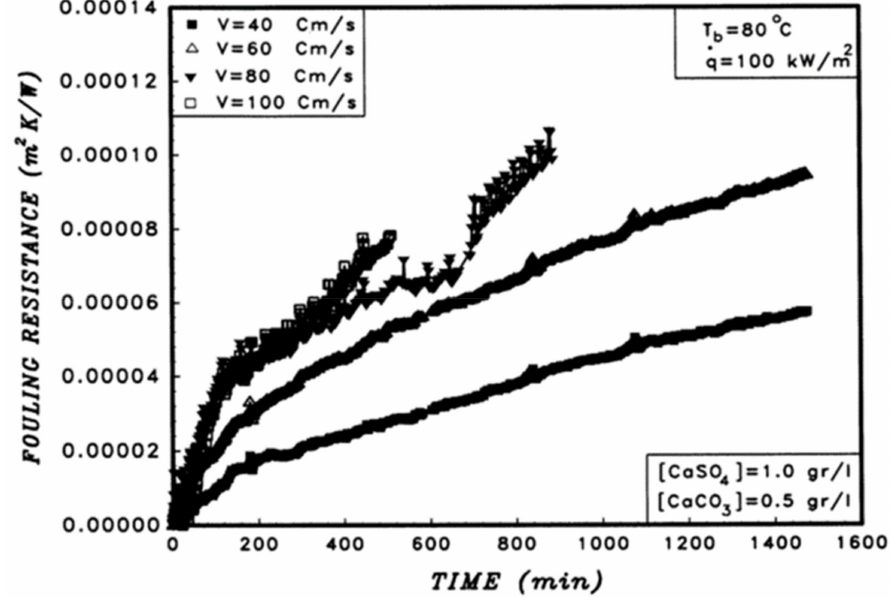
Figure 11. Variation of fouling resistance with time at different velocities [28].